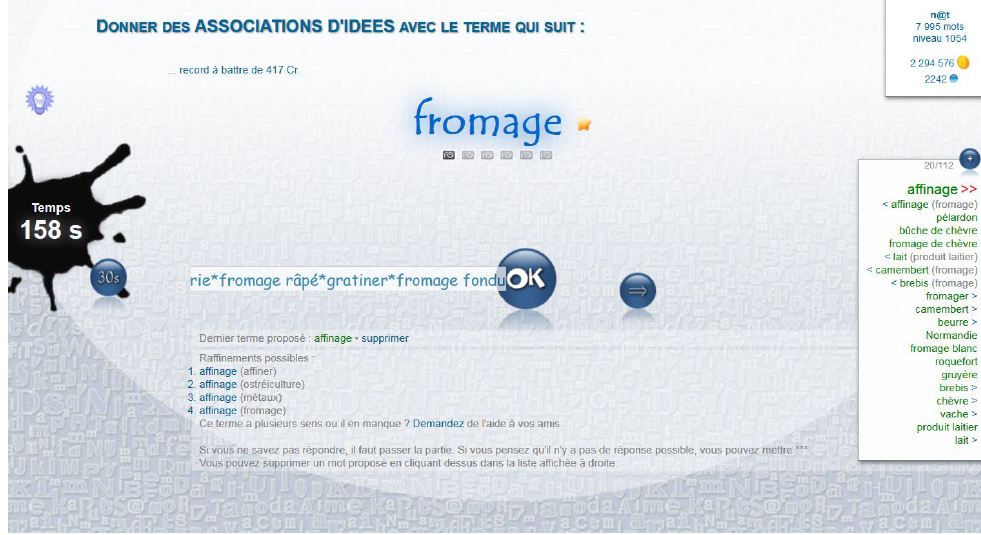
Figure 1: Screenshot of an ongoing game with the target verb fromage (cheese). Several propositions have been given by the user and are listed on the right hand side